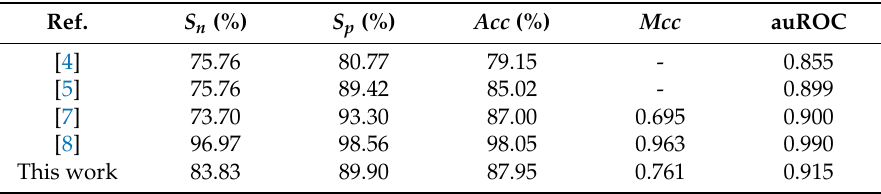
Table 2. Comparing the proposed method with other published methods.